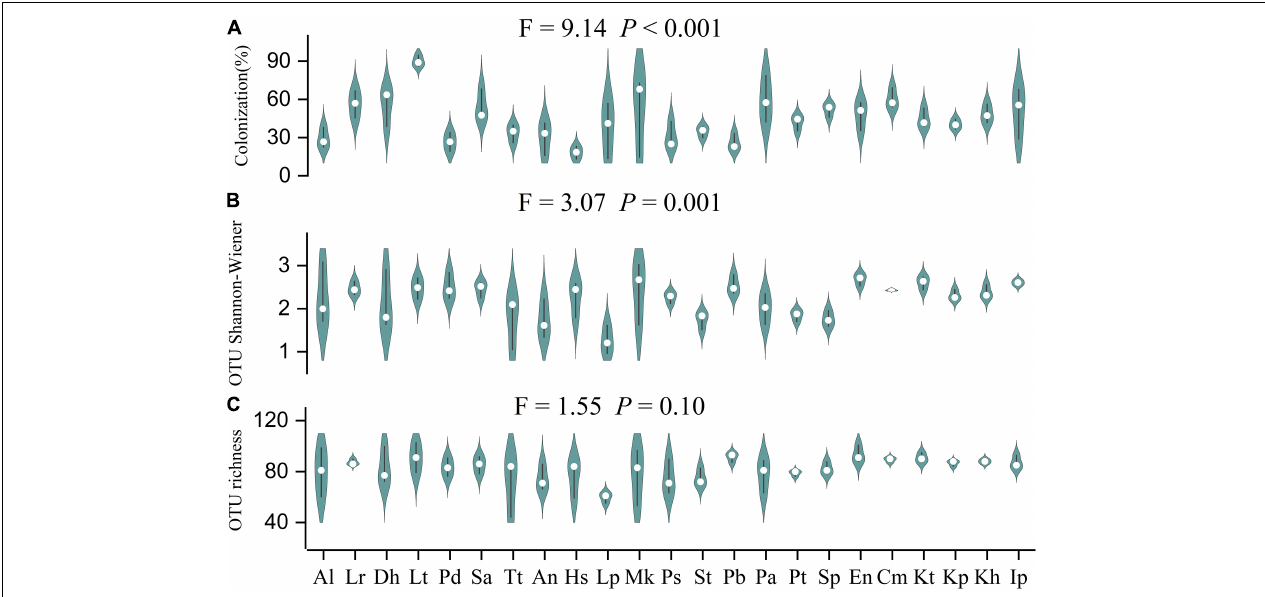
FIGURE 2 | Differences in Arbuscular mycorrhizal fungi (AMF) colonization (A) ; OTU Shannon-Wiener diversity index (B) ; and OTU richness (C) of 23 plant roots. Al: Ajuga lupulina ; Lr: Lamiophlomis rotata ; Dh: Dracocephalum heterophyllum ; Lt: Lancea tibetica ; Pd: Plantago depressa ; Sa: Saussurea tibetica ; Tt: Taraxacum tibetanum ; An: Artemisia nanschanica ; Hs: Heteropappus semiprostratus ; Lp: Leontopodium pusillum ; Mk: Morina kokonorica ; Ps: Polygonum sibiricum ; St: Stracheya tibetica ; Pb: Potentilla bifurca ; Pa: Potentilla anserina ; Pt: Poa tibetica ; Sp: Stipa purpurea ; En: Elymus nutans ; Cm: Carex moorcroftii ; Kt: Kobresia tibetica ; Kp: Kobresia pygmaea ; Kh: Kobresia humilis ; Ip: Iris potaninii .